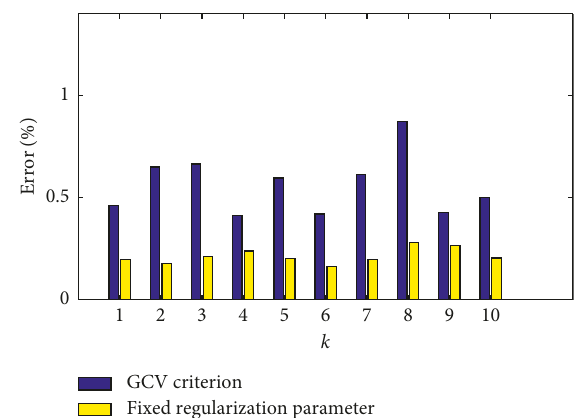
Figure 4: A comparison of identified errors of all stiffness between the GCV criterion and a fixed regularization parameter.